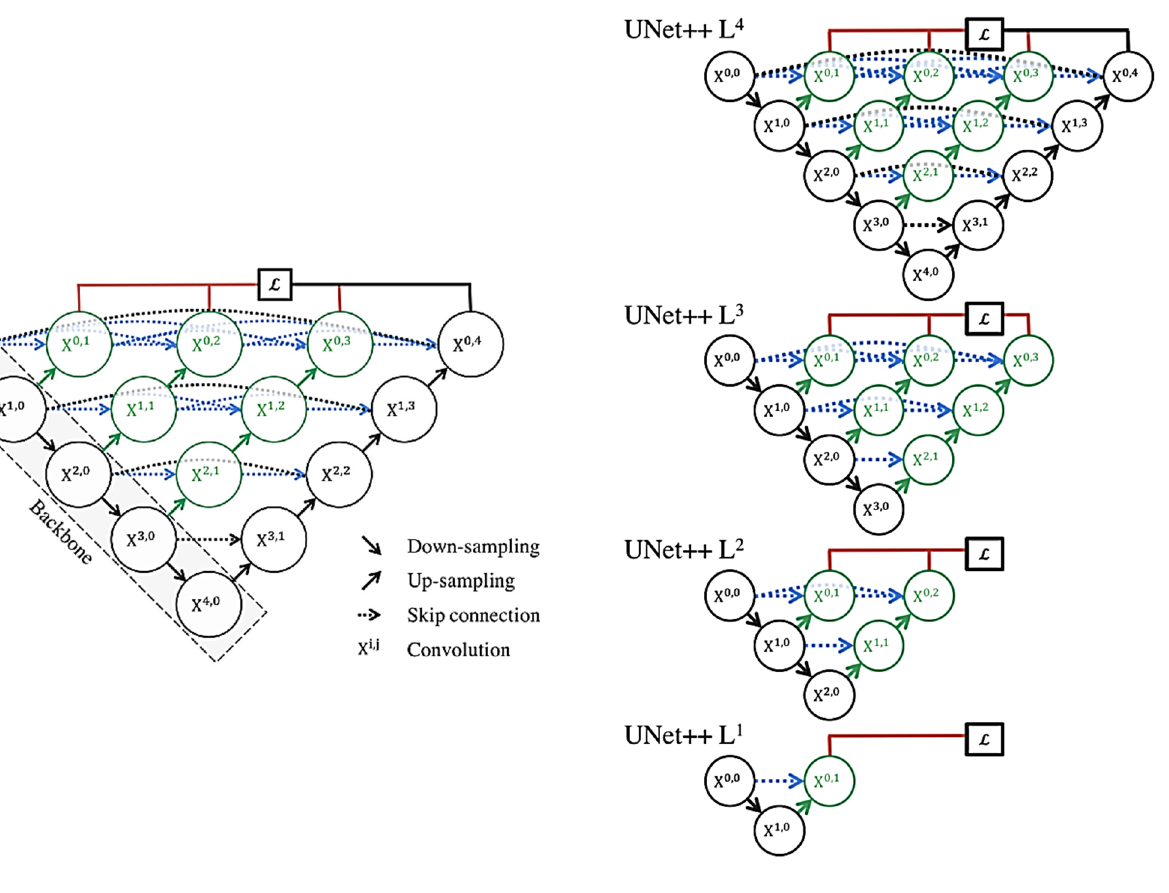
Figure 5. The overall structure of the U-Net++ architecture[17]